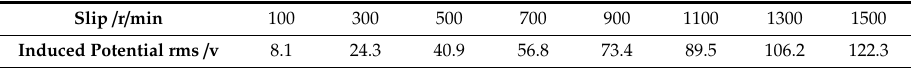
Figure 4. Test bench of PMSC. Table 1. Effective value of induced potential.